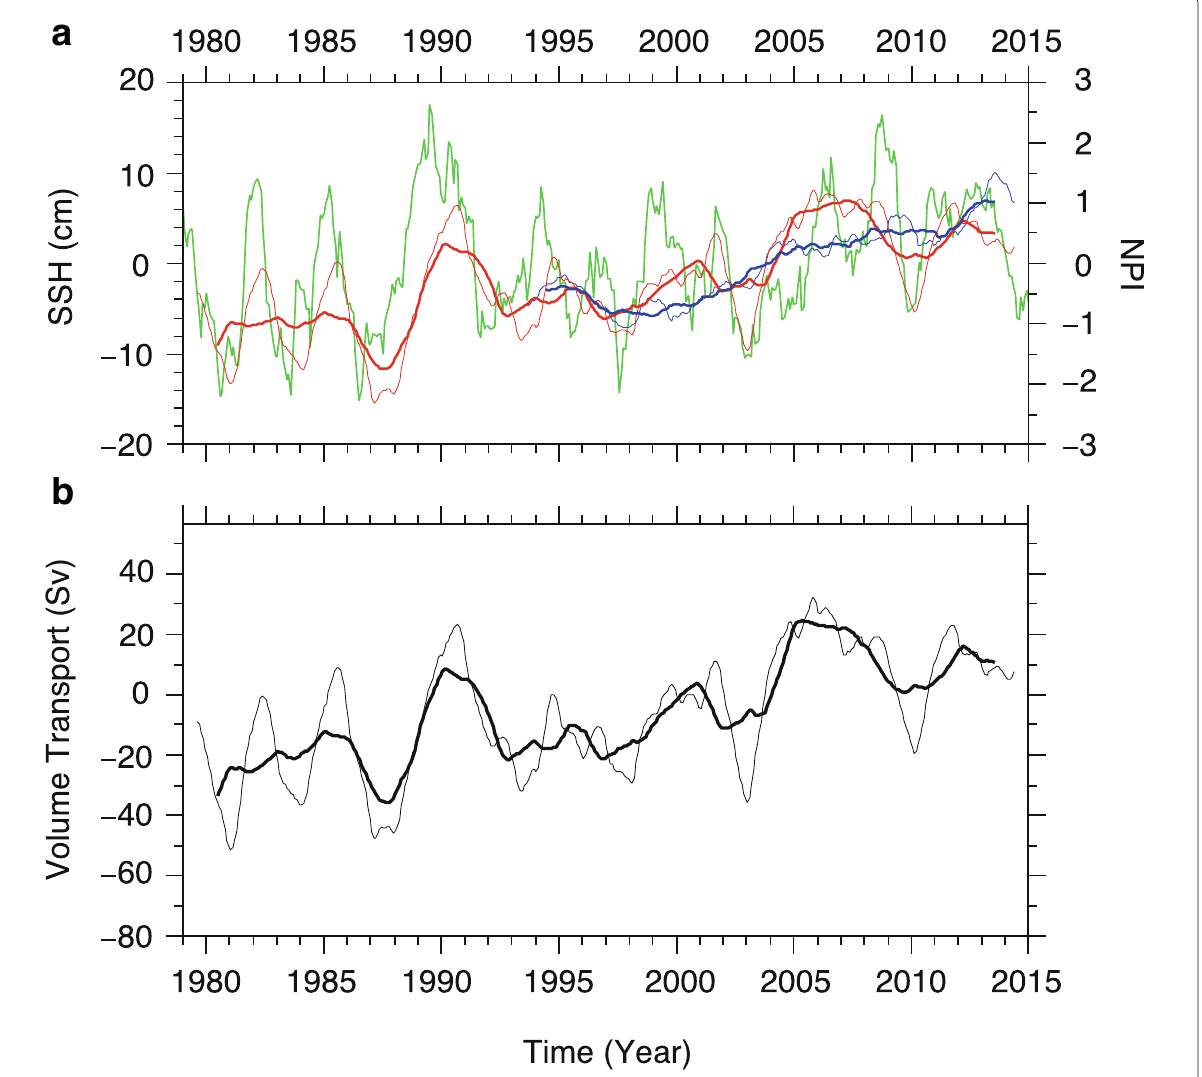
Fig. 7 Wind-driven variations in a SSH (cm) at station K2 (red line) and b absolute geostrophic volume transport (Sv) down to a depth of 4000dbar to the east of K2 (black line). Time series smoothed by 15- and 35-month running mean filters are indicated by thin and thick lines, respectively. Positive values in panel b indicate northward transport. For comparison, the observed SSH at K2 and the North Pacific Index (NPI) are shown by blue and green lines, respectively, in panel a . The NPI was smoothed by a 15-month running mean filter and normalized by the standard deviation